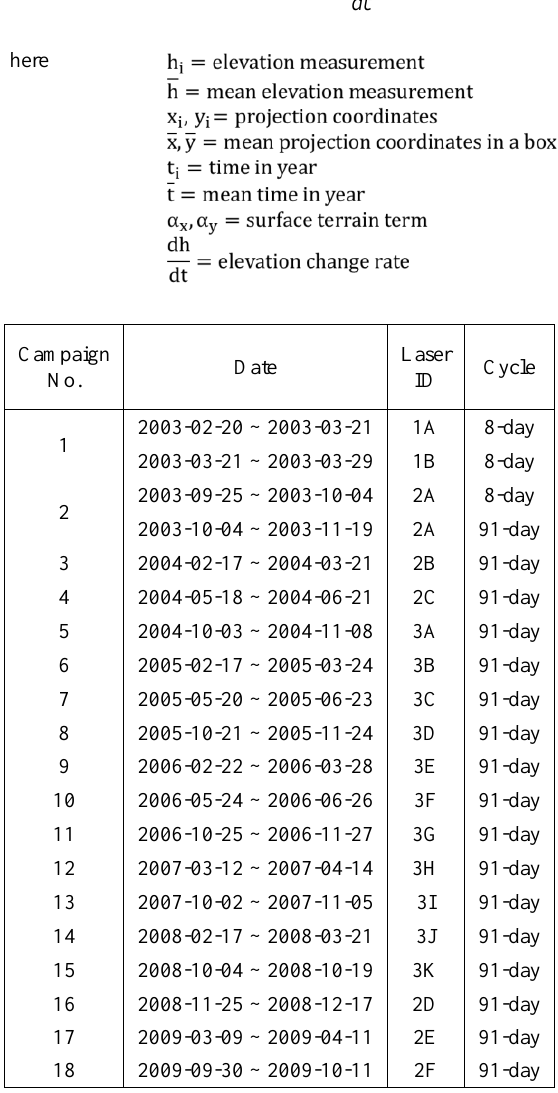
Table 1. ICESat campaigns and data used in this